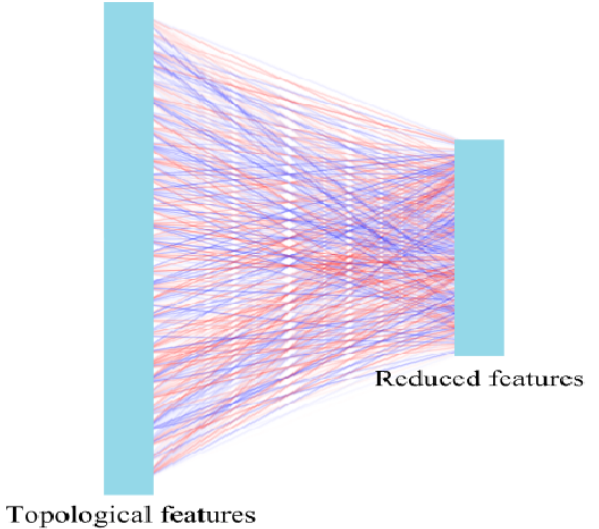
Figure 6. The fully connected sub-network that is used for reducing the topological features. For the reduced models (Models 6–8), we replace the blue layer in Figure 1 with this sub-network. The dimensional of this sub-network is 512. Weights of links in the sub-network are also optimized by the back-propagation